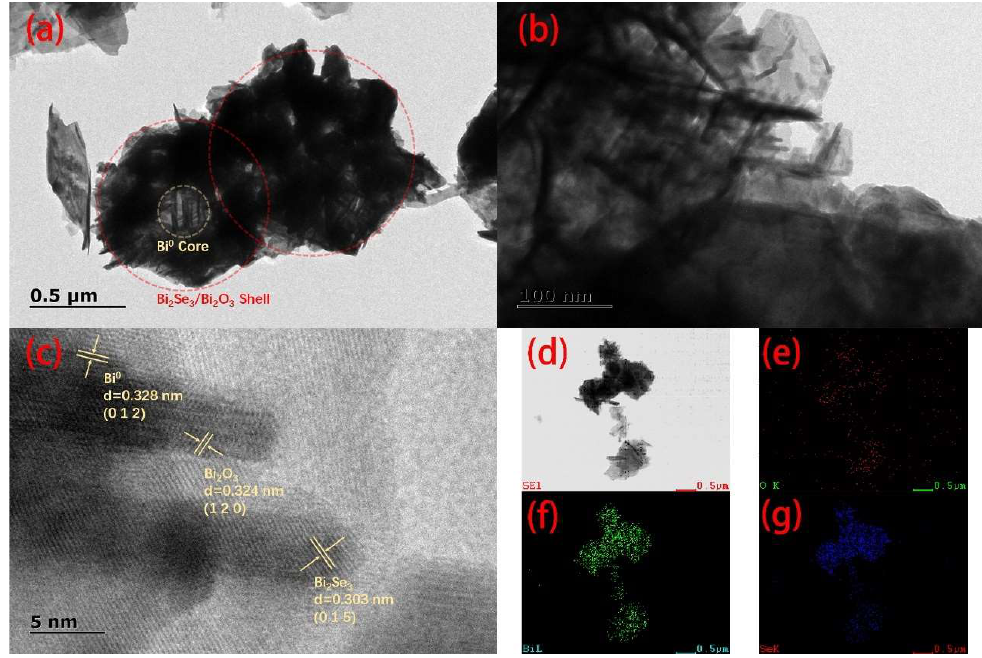
Figure 4. TEM image of 2BBOS: ( a ) 0.5 μm, ( b ) 100 nm, ( c ) 5 nm, and ( d – g ) element mapping of O, Bi, Se.